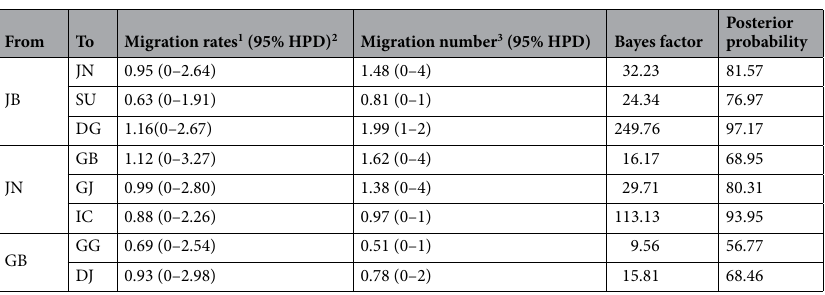
Table 4. Migration rates, migration number, Bayes factor, and posterior probability of spread of the Kor-O3 subgroup in South Korea. Only well-supported viral migrations (posterior probability > 0.5 and Bayes factor > 3) are displayed in this table. JB Jeollabuk-do, JN Jeollanam-do, SU Seoul, DG Daegu, GB Gyeongsangbuk-do, GJ Gwangju, IC Incheon, GG Gyeonggi-do, DJ Daejeon. 1 Actual migration rates were